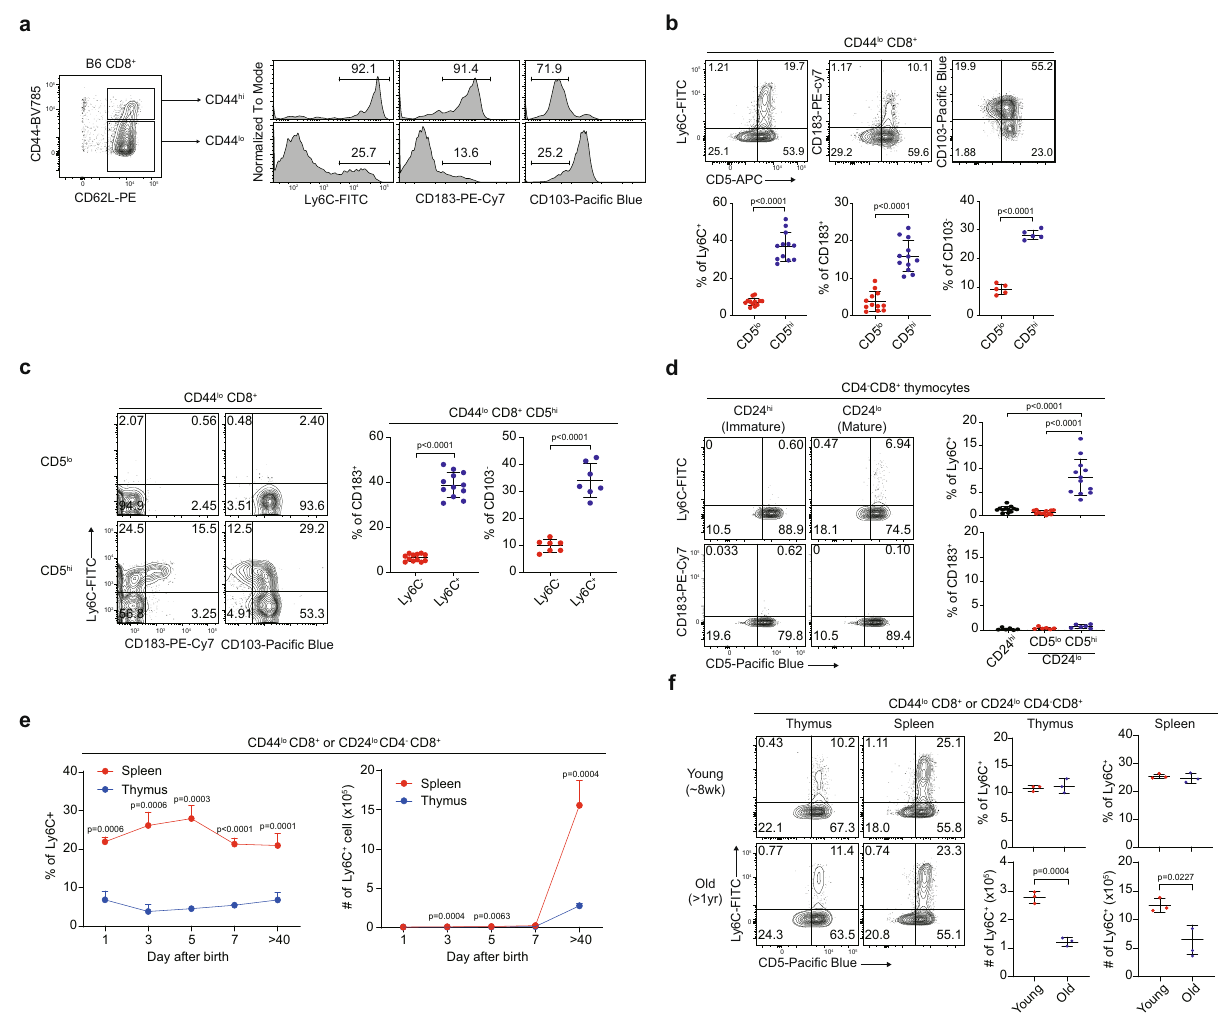
Fig. 1 Peripheral naive CD8 + T cells are phenotypically heterogeneous. a Ly6C, CD183, and CD103 expression on B6 CD44 lo and CD44 hi CD8 + T cells. b Percentage of Ly6C + , CD183 + , and CD103 − cells in CD5 lo and CD5 hi B6 naive CD8 + T cells ( n = 12 mice for Ly6C + and CD183 + , n = 5 mice for CD103 − ). c Percentage of CD183 + and CD103 − cells in Ly6C − and Ly6C + CD5 hi B6 naive CD8 + T cells ( n = 12 mice for CD183 + , n = 7 mice for CD103 − ). d Percentage of CD183 + and Ly6C + cells in CD24 hi, CD24 lo CD5 lo , and CD24 lo CD5 hi B6 CD4 − CD8 + thymocytes ( n = 12 mice for Ly6C + , n = 6 mice for CD183 + ). e Splenic and thymic Ly6C + B6 naive CD8 + T cell changes over time after birth (n = 3 mice for each group). f Splenic and thymic Ly6C + B6 naive CD8 + T cells in young and old mice ( n = 3 mice for each group). Statistical signi fi cance was con fi rmed by two-tailed unpaired Student ’ s t -test. Results are shown as mean ± SD. Data representative of 2 – 3 independent experiments. Source data are provided as a Source data